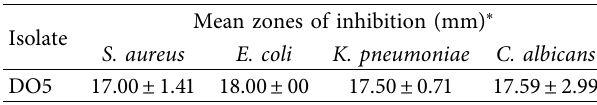
Figure 1: Incubation time effect on antimicrobial activity of isolate DO5 against K. pneumoniae . Table 4: Antimicrobial activity of supernatant of isolate DO5.